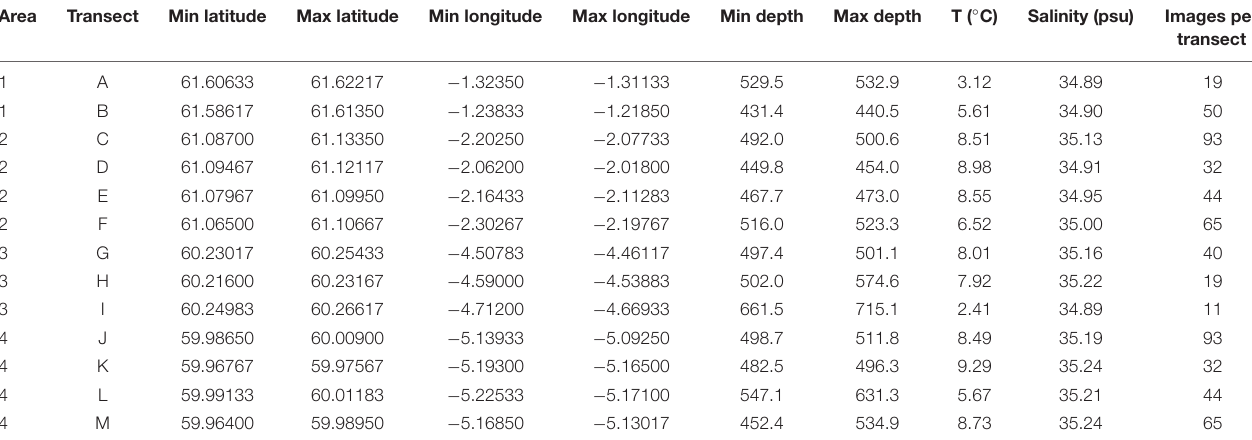
FIGURE 1 | Wider study area (Left) and camera transects inside (Area 2: transects C–F) and outside the Faroe-Shetland Channel Nature Conservation Marine Protected Area (FSC NCMPA) (Area 1: transects A,B; Area 3: transects G–I; Area 4: transects J–M) (Right) . See also Table 1 . TABLE 1 | Coordinates and depth values for each of the transects inside (Area 2) and outside (Area 1, Area 3, Area 4) the Faroe-Shetland Channel Nature Conservation Marine Protected Area (FSC